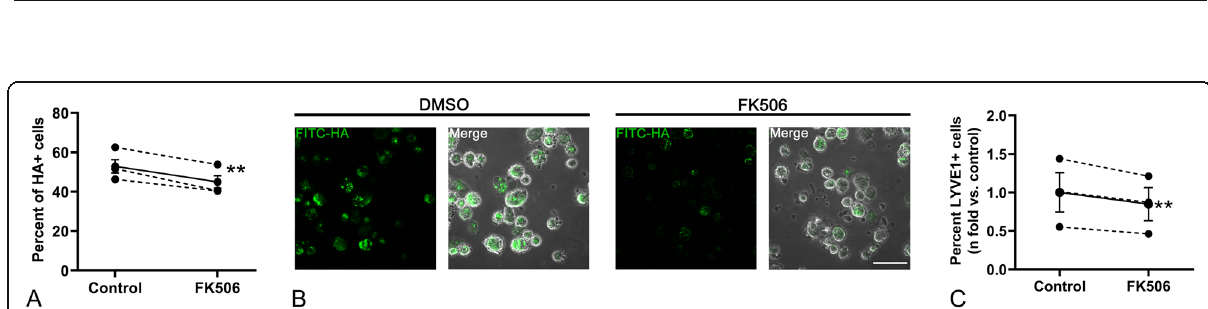
Fig. 6 FK506 reduces HA uptake in vitro and LYVE-1 expression ex-vivo in PCLS. LEC were plated in 6-well plates and treated with vehicle or FK506 (15 ng/mL) for 72 h. Cells were then incubated in media containing 1000 μ g/mL of FITC-HA for 5 h. Percentage of FITC-positive cells ( a ) were analyzed by flow cytometry. Representative images of immunofluorescent staining of single and merged images of HA (green) and DIC without and with treatment with FK506 (15 ng/ml) for 72 h ( b ) (Size bar: 50 μ m). Precision cut lung slices obtained from dt-Tomato Prox1 mice, treated with FK506 (15 ng/mL) or DMSO for 7 days, followed by digestion and cell isolation. Percent LYVE1+/dt-Tomato-Prox1+ cells ( c ) were analyzed by flow cytometry. Results for flow cytometry are expressed as mean ± SEM of 3 experiments. Dotted line represents each data point and solid line represents mean of 3